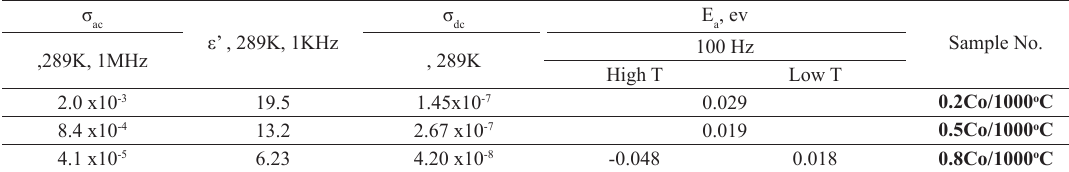
), dc conductivity, capacitance, dielectric constants of the samples prepared Table 4. Room temperature values of the activation energies (E a by microwave method and sintered at 1000 o C and ac conductivity at 1 MHz and 1 kHz with an experimental error of ±2%. σ ac ε’ , 289K, 1KHz